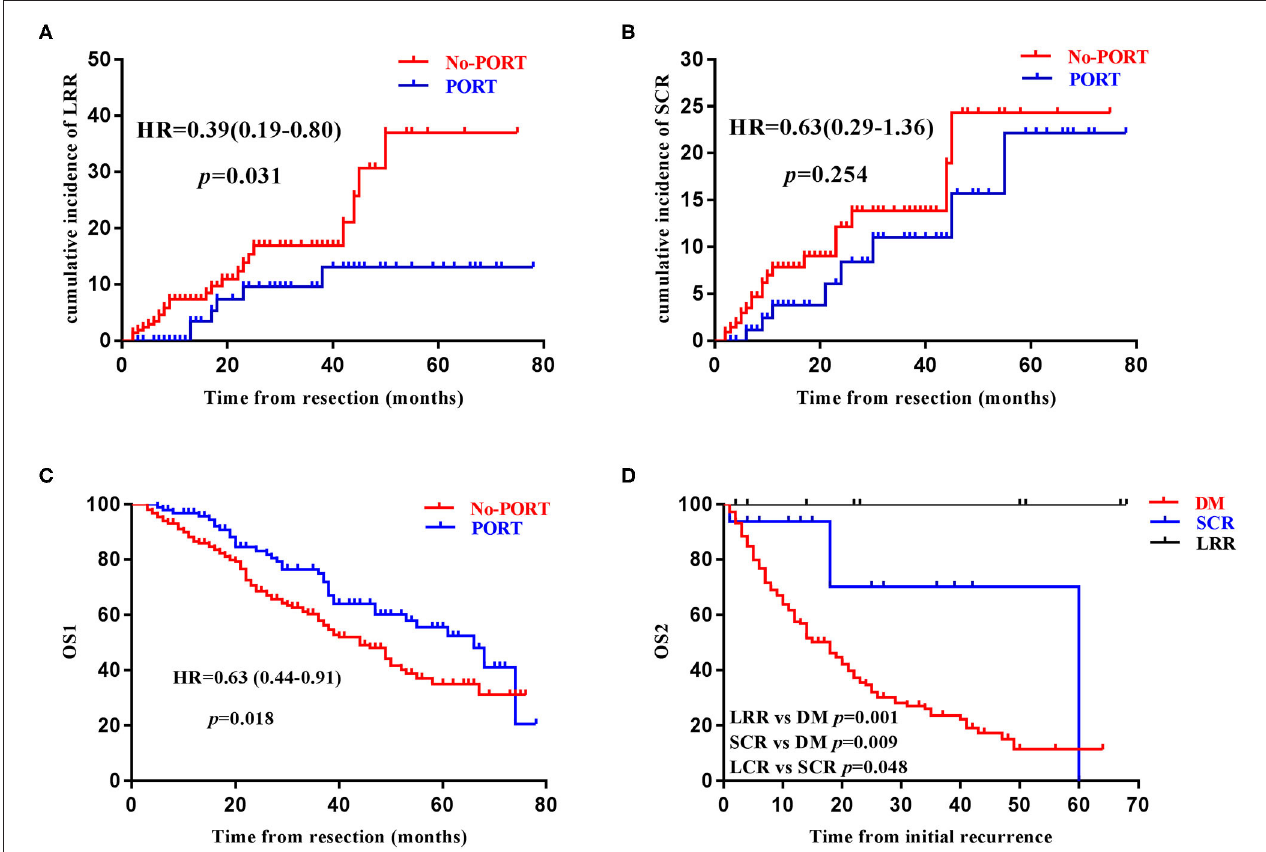
FIGURE 3 | Prognostic significance of postoperative radiotherapy and supraclavicular recurrence. The impact of postoperative radiotherapy (PORT) on loco-regional recurrence (LRR) (A) , supraclavicular recurrence (SCR) (B) , overall survival (OS1) (C) , in the entire cohort. Kaplan–Meier survival curve stratified by the disease recurrence patterns among patients with recurrent disease (D)